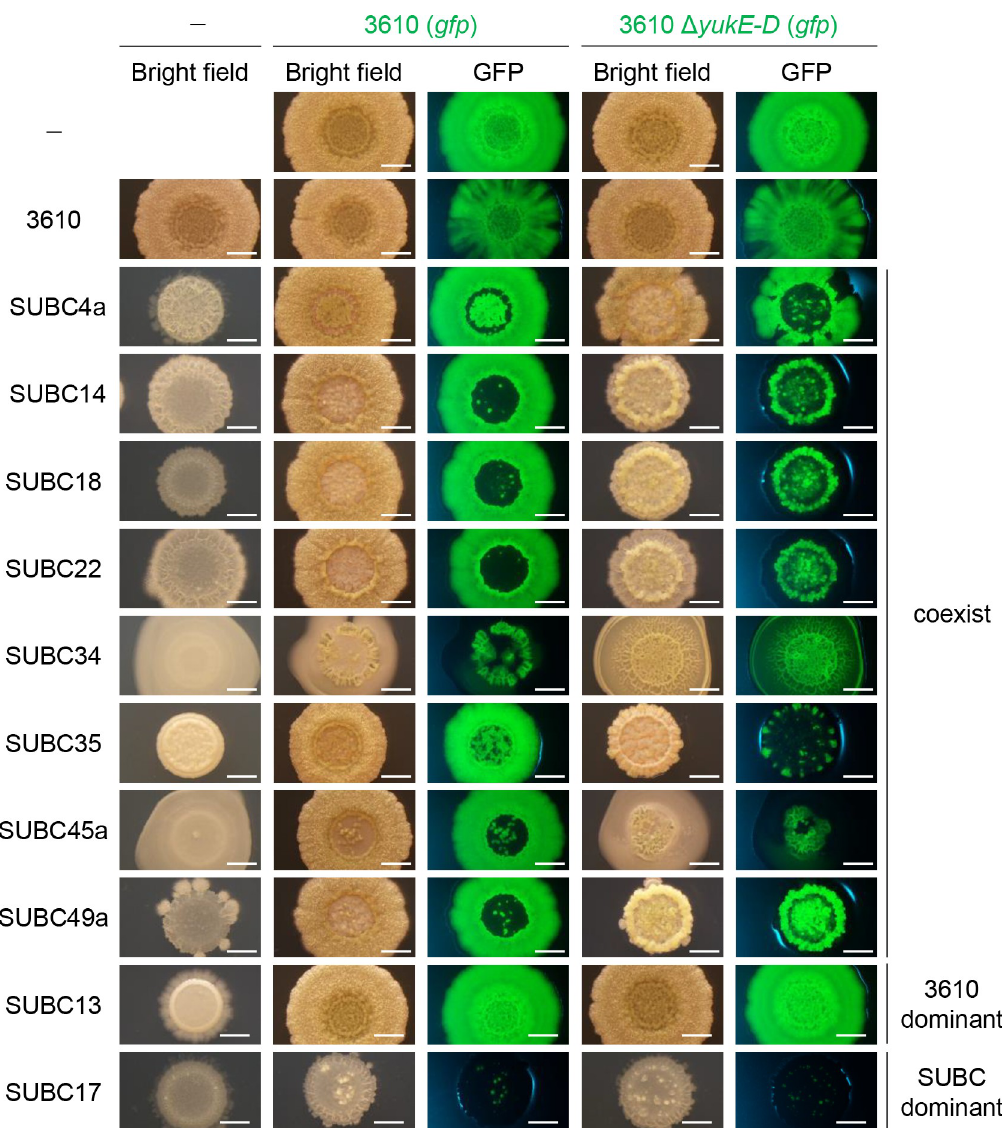
Fig 8. LXG toxins are effective against natural isolates of B . subtilis . The GFP-labeled strain 3610 or the T7SS mutant Δ yukE – D was co-cultured with a B . subtilis natural isolate at a ratio of 1:1 on MSgg medium. After 48 h of cultivation, the morphology and GFP fluorescence of colonies were observed with a stereomicroscope. Single-strain cultures are shown as references. Selected results are shown; see S10 Fig for complete results. The experiments were repeated twice and confirmed the reproducibility. The classification of co-cultured colonies is indicated on the right. Scale bar, 2